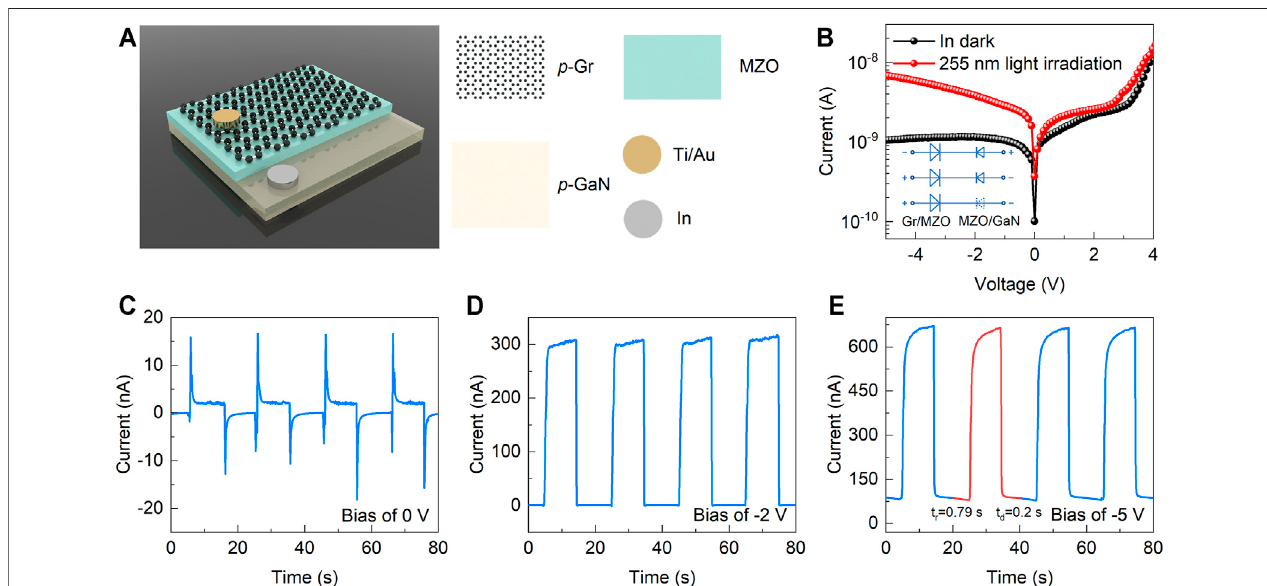
FIGURE 3| (A) Structure diagram ofthe device. (B) The I-V curve ofthe device under adark environment and 255 nm illumination, the lower left corner reveals the schematic diagram of the device ’ s recti fi cation principle. (C) When the device is under 0 bias voltage, the current changes with time, that is, the I-t curve, the rise time is 0.56 s, and the decay time is 0.21 s, the photocurrent is 2 nA. (D) The I-t curve under − 2 V bias voltage has a rise time of 0.16 s and a decay time of 0.70 s, the photocurrent is 300 nA. (E) The I-t curve under − 5 V bias voltage has a rise time of 0.79 s and a decay time of 0.20 s, the photocurrent is 670 nA.